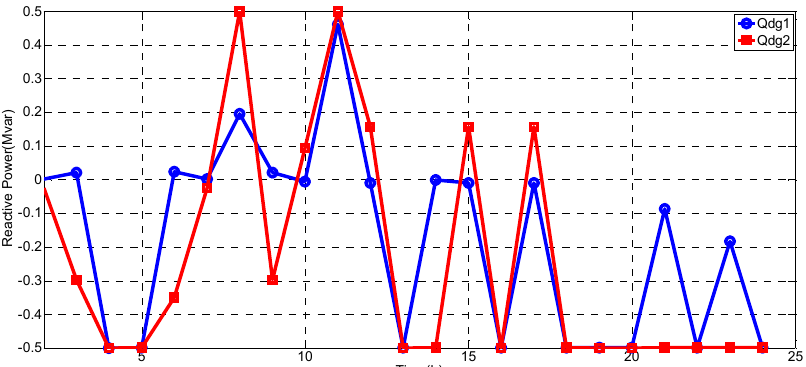
Figure 27. Reactive power reference of case 1 for CVR. Table 8. Comparison of the number of tap operations, PI total, sum of reactive power with/without proposed method of case 1 for CVR.